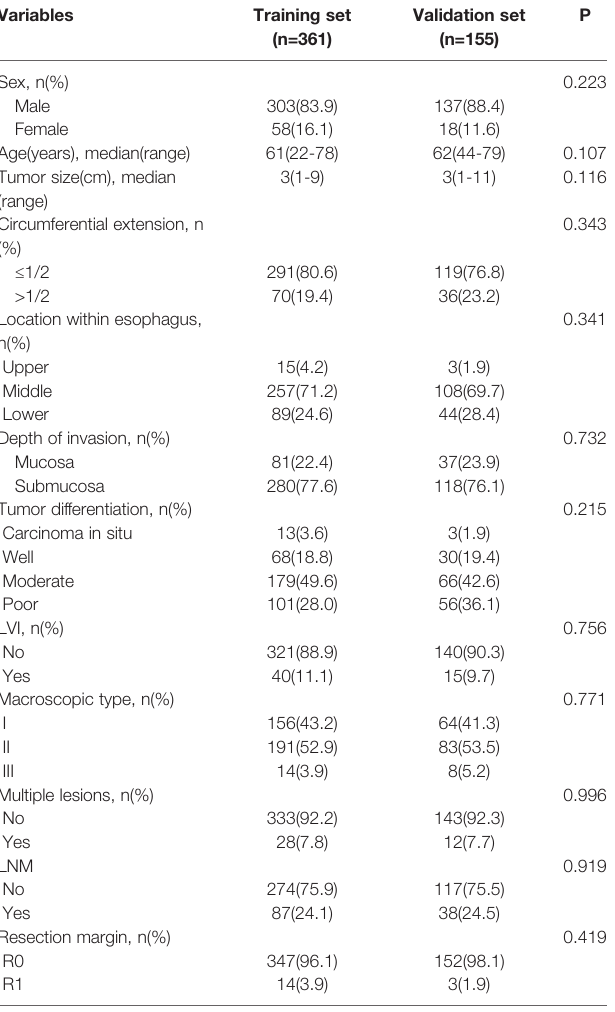
TABLE 3 | Multivariate logistic analysis of risk factors for lymphovascular invasion in training set. Factors